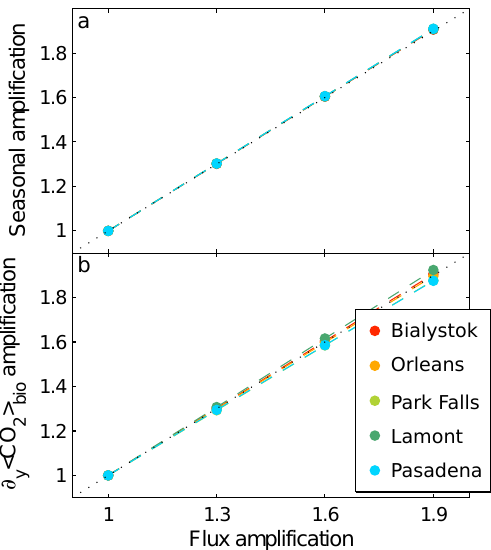
Fig. 8. (a) Amplification to the seasonal cycle amplitude in sim- ulations with amplified NEE versus CASA NEE. Scaling NEE throughout the Northern Hemisphere increases the seasonal cycle amplitude proportionally at each of five Northern Hemisphere TC- CON sites. (b) Amplification to the estimated gradients in sim- ulations with amplified NEE versus CASA NEE. The estimated \ ∂ h CO i y h CO 2 i bio , also increases proportionally at 2 bio gradient, each of the TCCON sites. The unit diagonal is plotted in each panel. Site acronyms are defined in Table